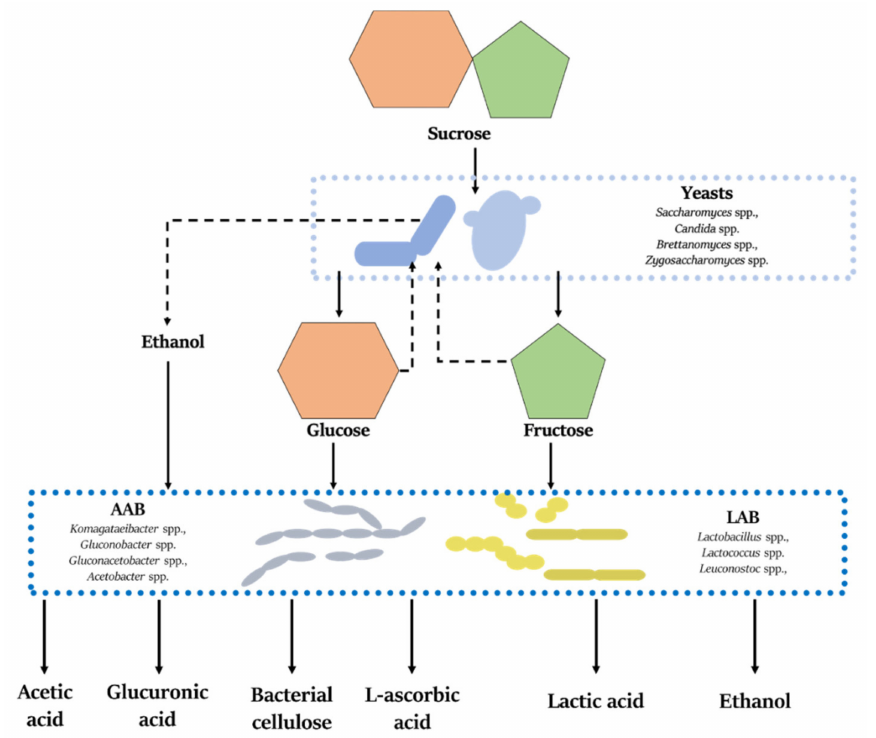
Figure 3. Scheme of sucrose metabolism by SCOBY along with major